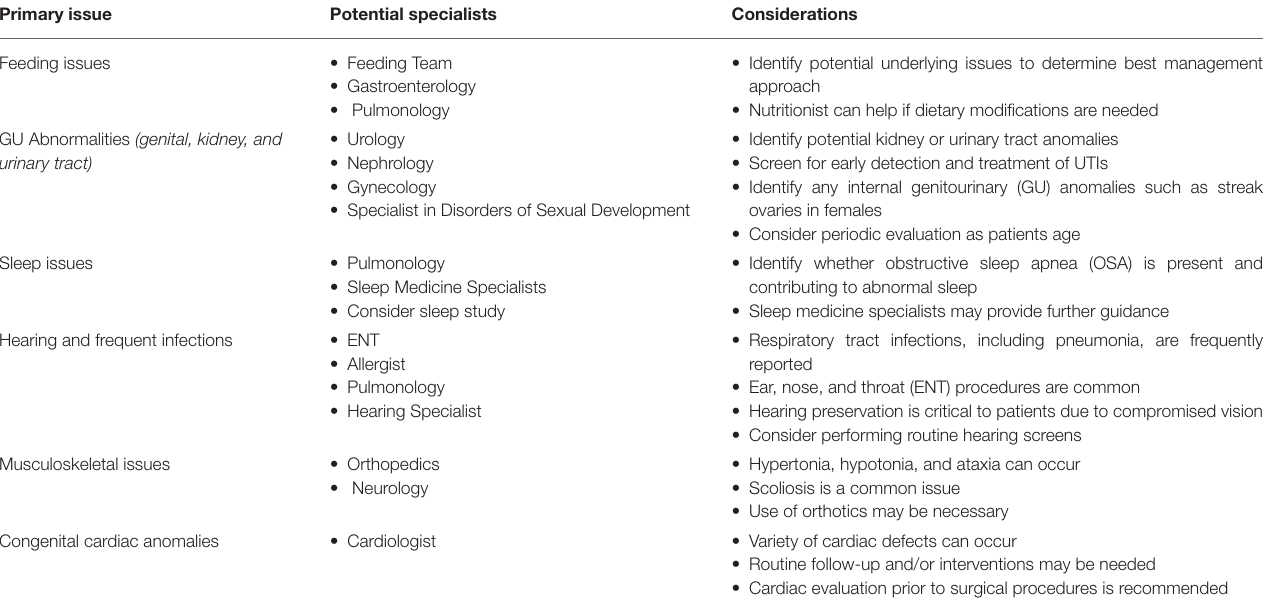
TABLE 9 | Additional health care considerations for patients with WAGR